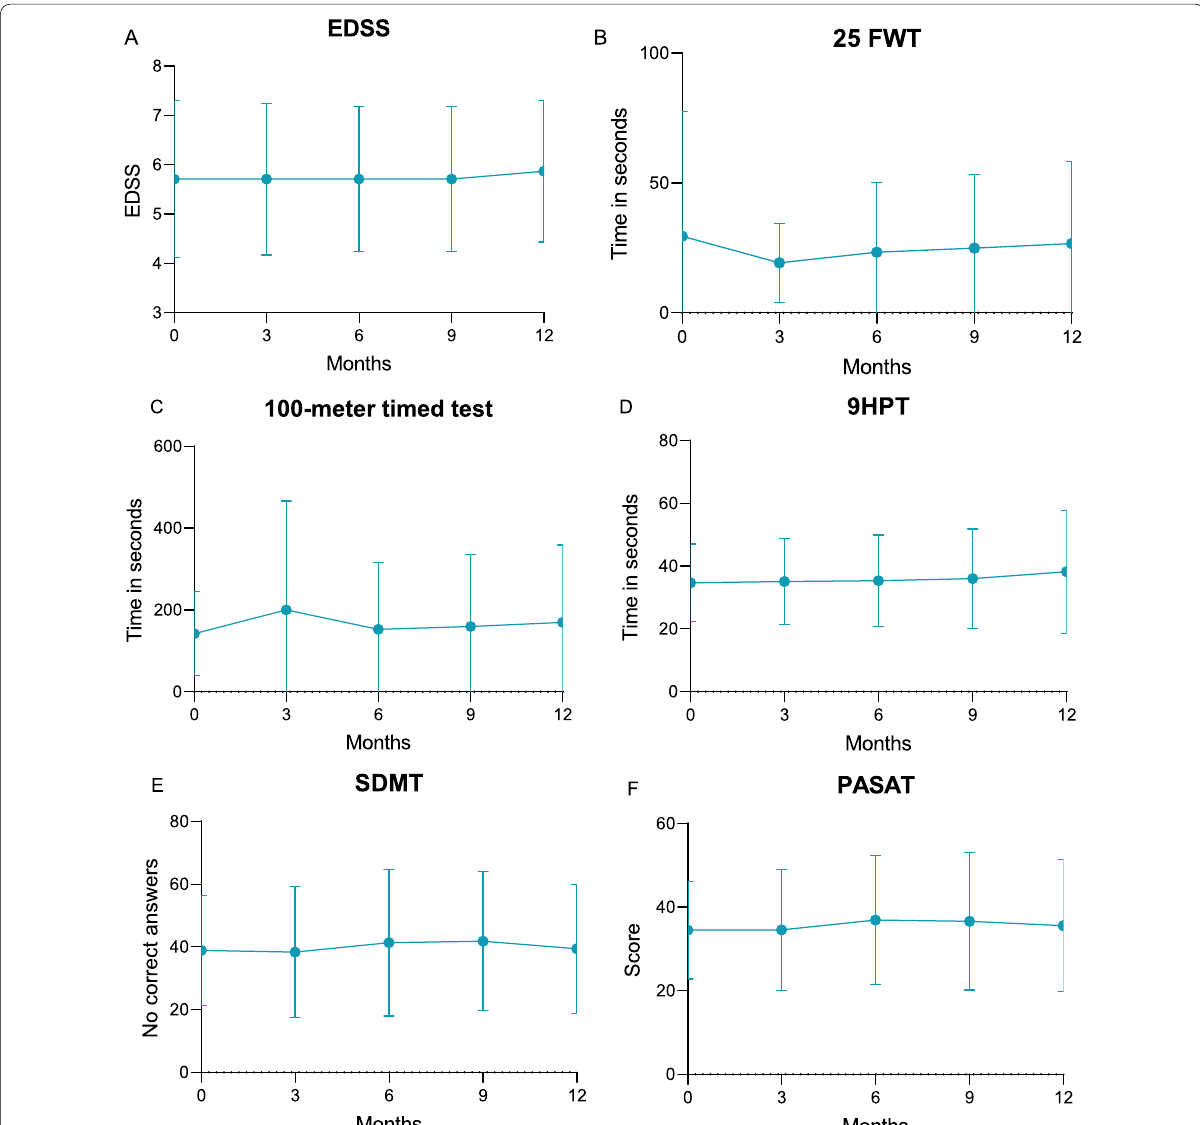
Fig. 3 Measurements of therapeutic efficacy over time. EDSS (part A ), 25 FWT (part B ), 100‑m time test (part C ), 9 HPT (part D ), SDMT (part E ), PASAT (part F ) are stable over time. EDSS, Expanded Disability Status Scale; 25 FWT, 25‑timed food walking time test; 9HPT, 9‑hole peg test; SDMT,